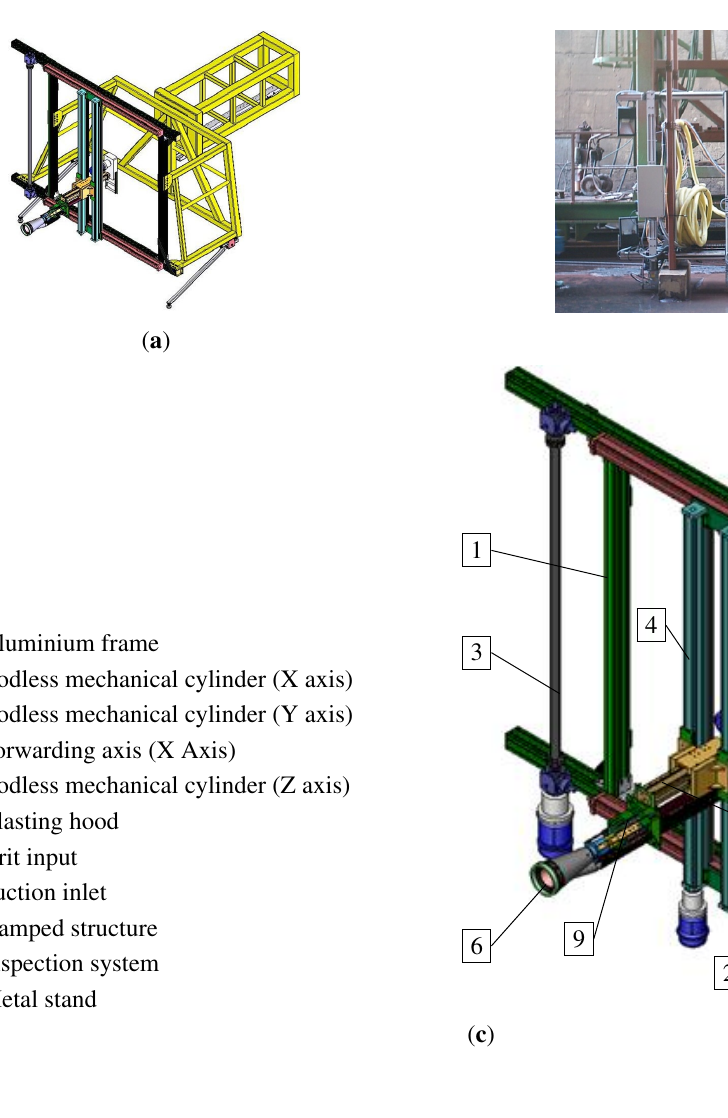
Figure 6. XYZ Table design. Secondary structure. ( a ) 3D view of the XYZ Table; ( b ) Developed XYZ Table; ( c ) Elements of the XYZ